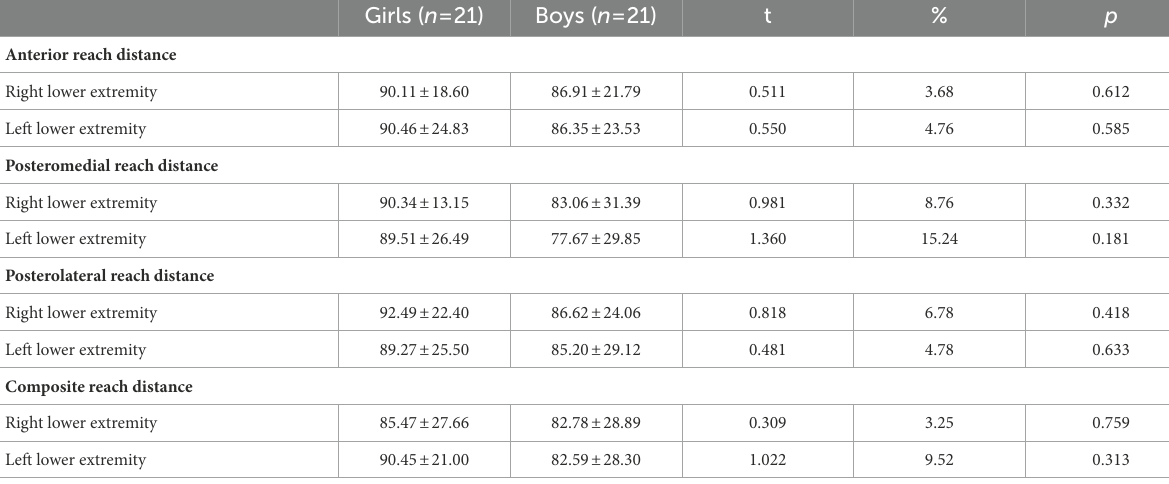
TABLE 5 The results of the independent sample T -test, which was conducted to determine whether there is a significant difference between the balance motor performance capacity post-test Y Balance Test ANT, PM, PL and Composite reach distance mean scores of gender.